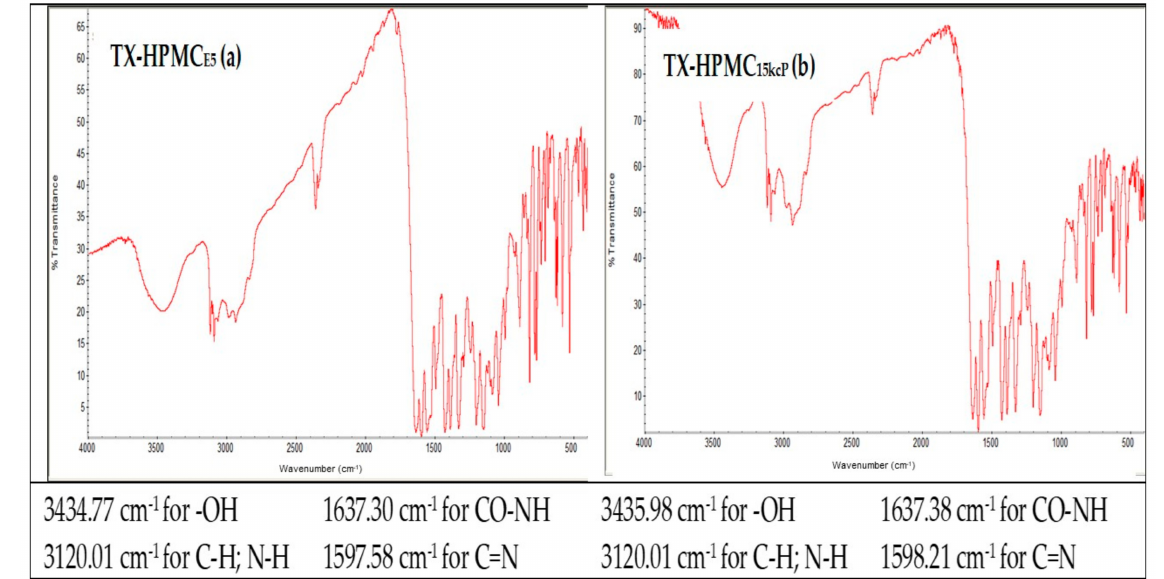
Figure 2. The FT-IR spectra of physical mixtures: TX-HPMC E5 ( a ) and TX-HPMC 15kcP ( b